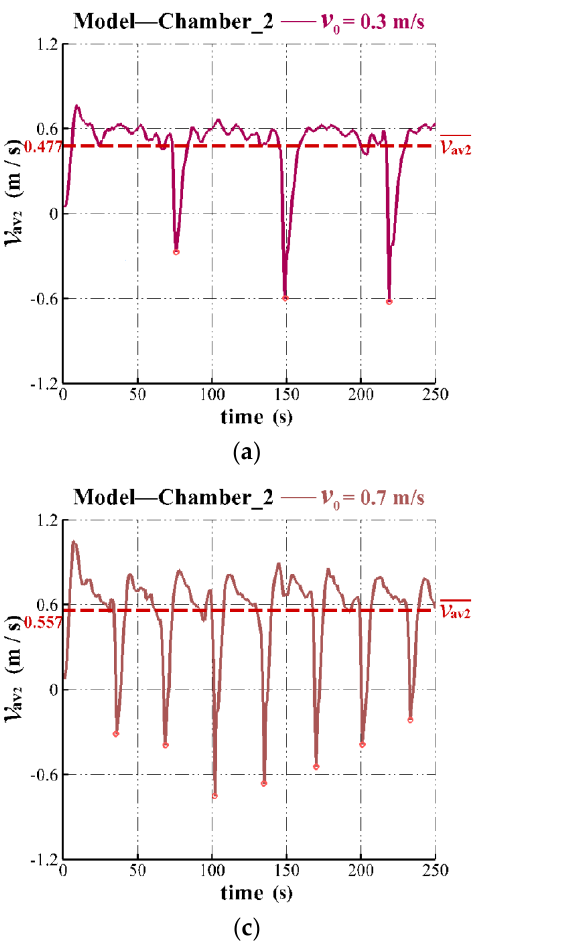
Figure 10. Velocity in the deflector plate outlet for different air release rates of ( a ) 0.3, ( b ) 0.5, ( c ) 0.7, and ( d ) 1.0 m/s. The pink circles indicate the minimum velocities of the deflector plate outlet, and the red dashed lines indicate time-averaged velocities of deflector plate outlet. Table 4. Computational results of the oxygenation performance with different air release